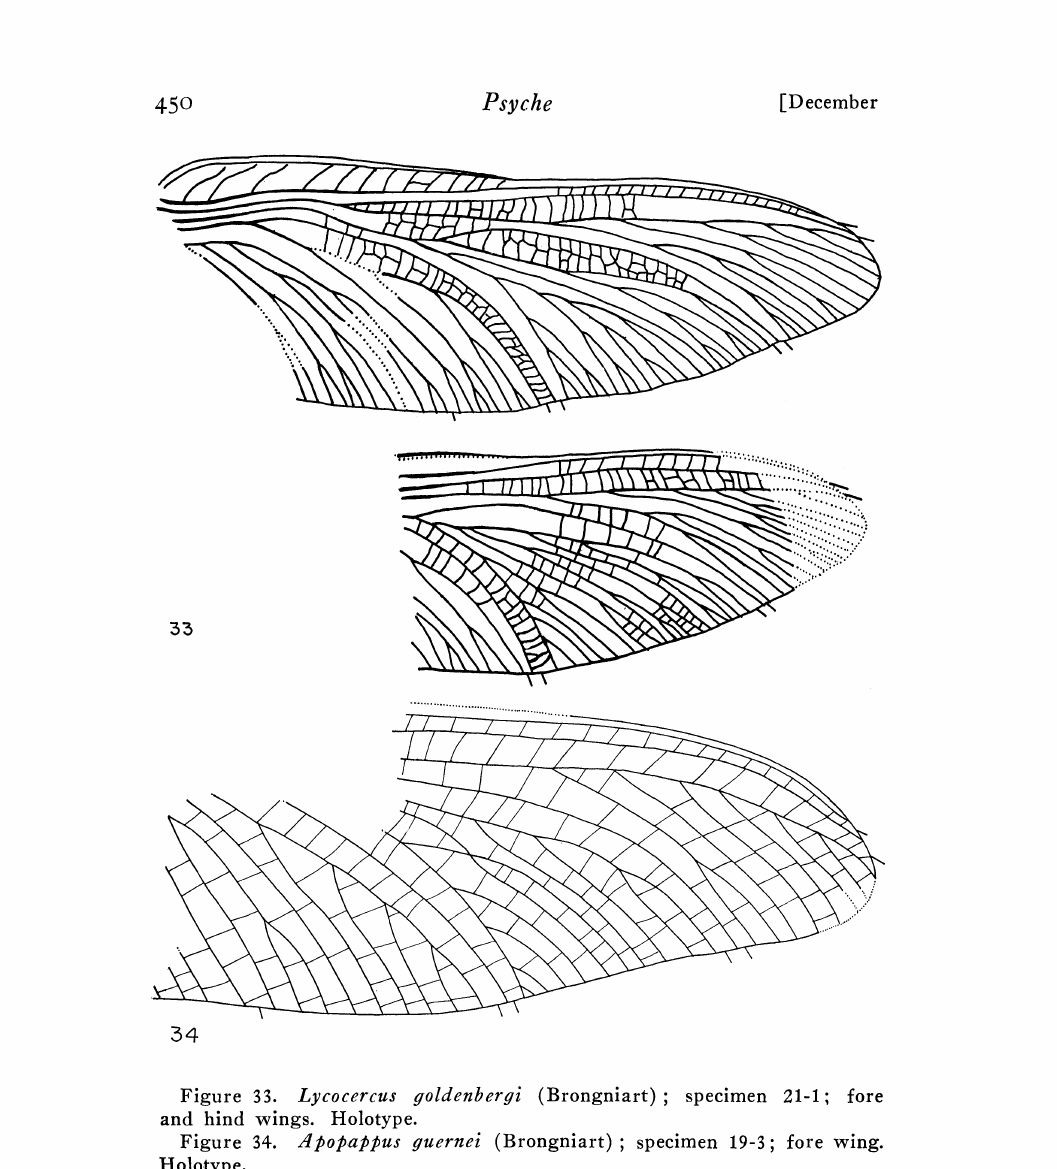
Figure 33. Lycocercus yoldenbergi (Brongniart); specimen 21-1; fore and hind wings. Holotype. Figure 34. l#op,a##us guernei (Brongniart) specimen 19-3; fore wing.